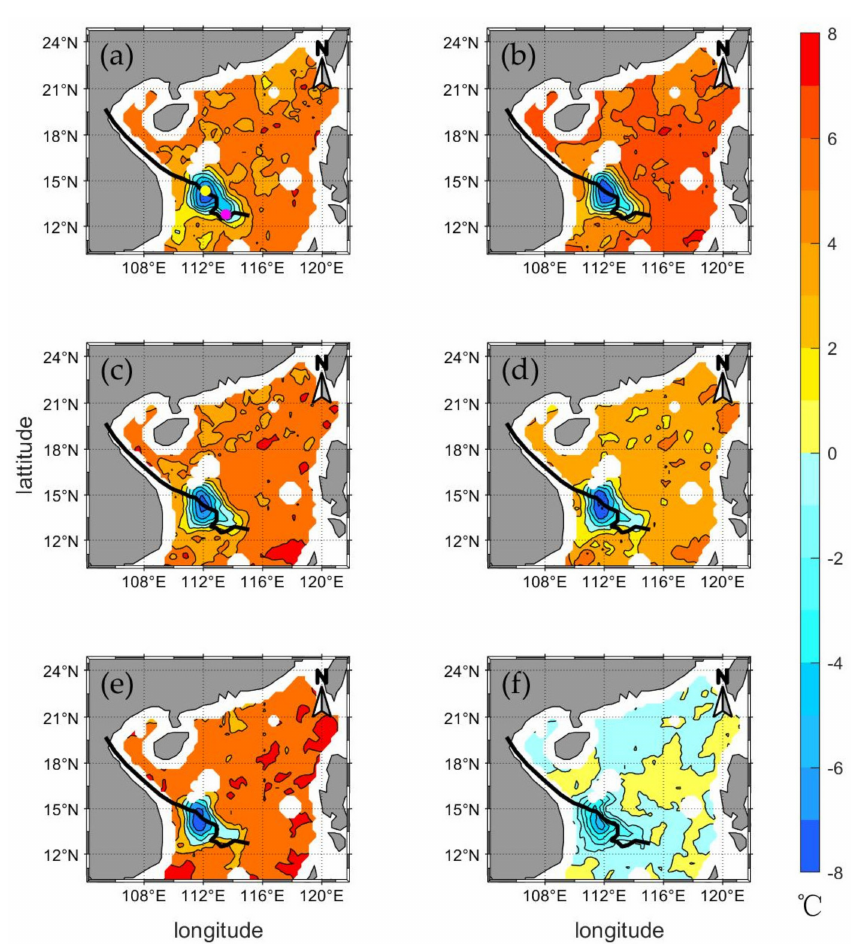
Figure 11. The track of typhoon Kai-tak and the temperature change after its passage in 2005: ( a ) Describes the change of SSTA on the first day after the typhoon. The magenta dot represents the typhoon center at 18:00 on 28 October, the yellow dot represents the typhoon center at 18:00 on 30 October; ( b – f ) Describes the changes in SSTA 2–6 days after the